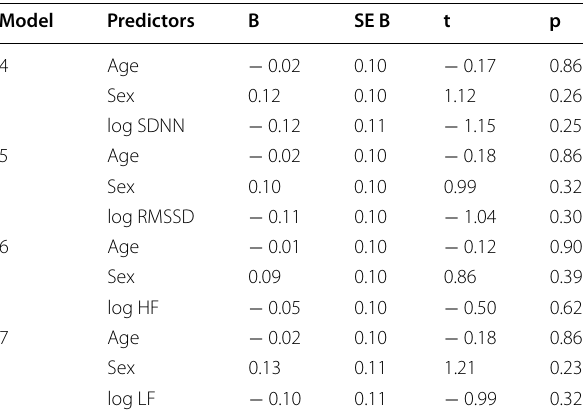
Table 2 Regression analysis predicting loneliness as a function of